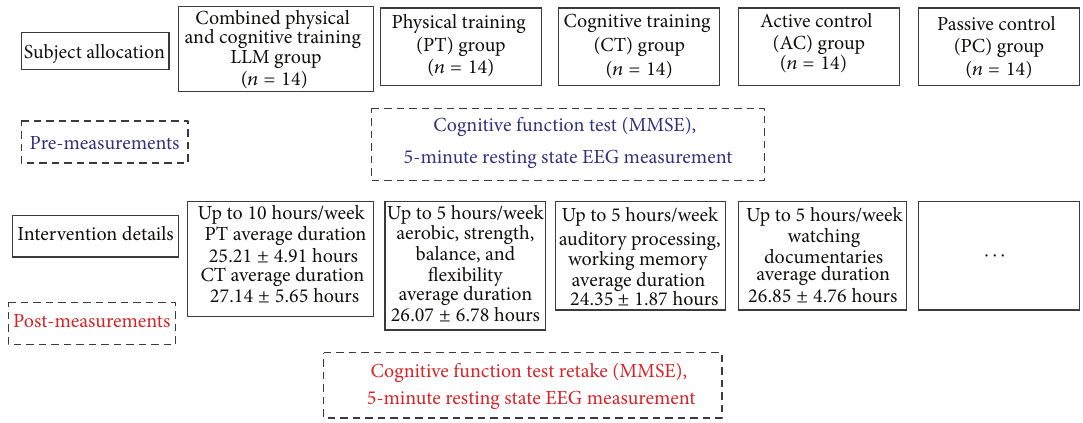
Figure 1: Flow of participants within the 3 experimental and 2 control